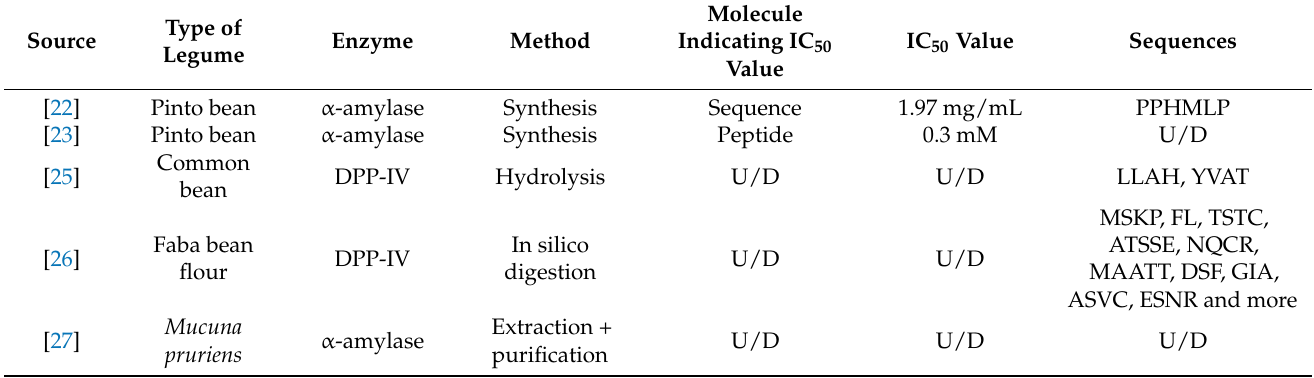
Table 2. IC 50 values and bioactive peptide sequences of investigated legumes with activity against enzymes breaking down